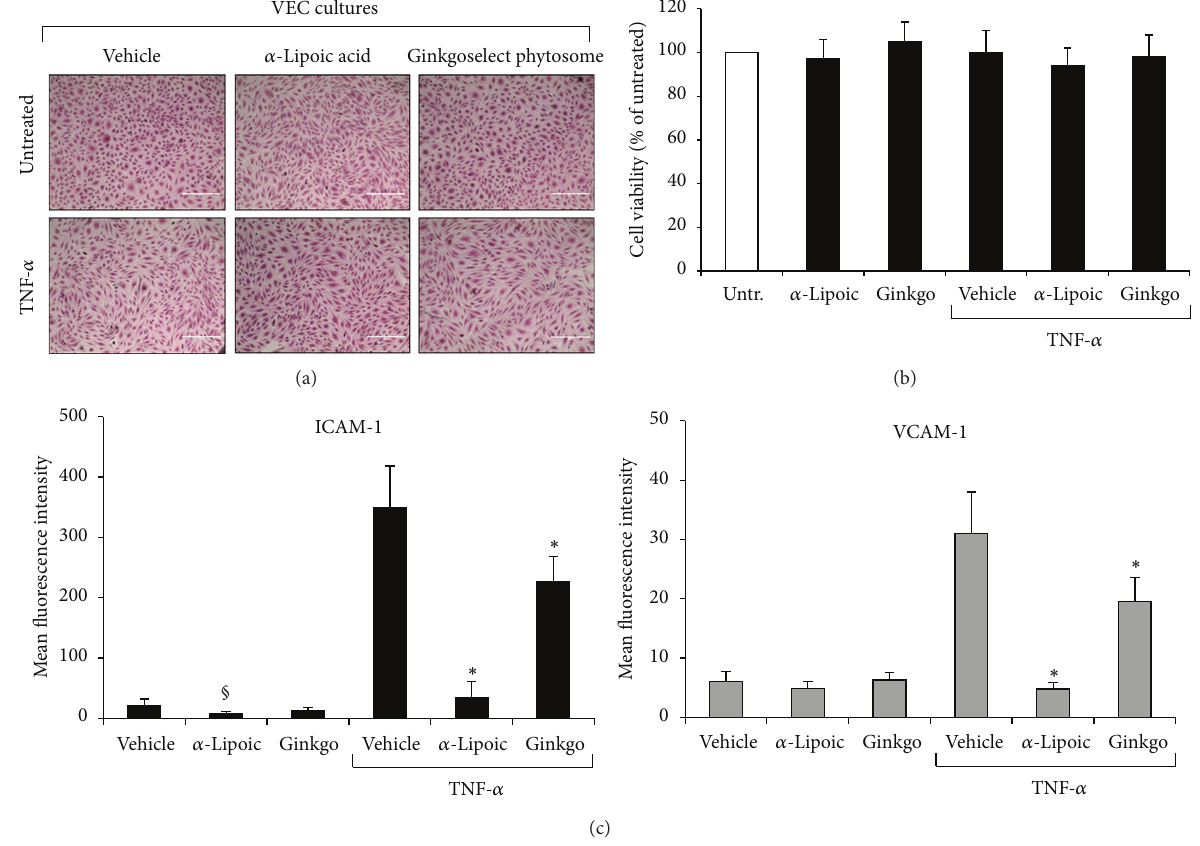
Figure 2: Lack of cell toxicity and anti-inflammatory properties of 𝛼 -Lipoic acid and Ginkgoselect phytosome in CVD-VEC model. Endothelial cells were exposed to TNF- 𝛼 (5ng/mL), Ginkgoselect phytosome, and 𝛼 -Lipoic acid (both at 100 𝜇 g/mL) used either alone or in combination (1 hour of pretreatment with Ginkgoselect phytosome and 𝛼 -Lipoic acid before addition of TNF- 𝛼 ) and analyzed after 24 hours of treatments. In (a), representative fields of cultures treated as indicated were observed by light microscopy after haematoxylin and eosin staining. In (b), cell viability is shown as percentage of untreated cultures (Untr.) set to 100%. Data are reported as means ± SD of three independent experiments. In (c), data are expressed as mean fluorescence intensity (MFI) after subtraction of background fluorescence from vehicle-treated cells. Results are reported as means ± SD of four independent experiments. ∗ 𝑃 < 0.05 compared to vehicle and TNF- 𝛼 treated VEC; § 𝑃 < 0.05 compared to vehicle treated